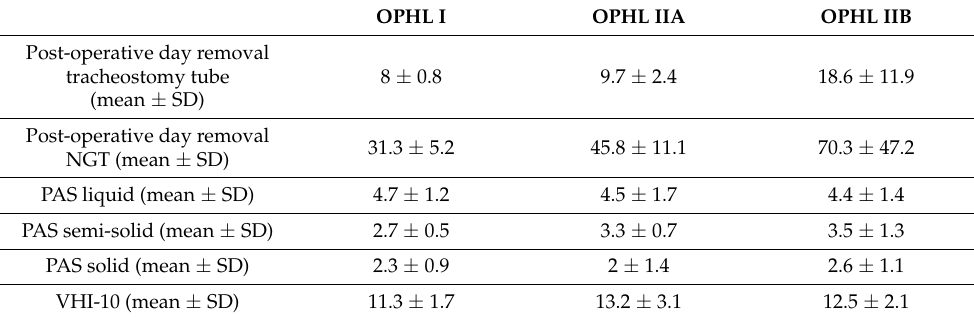
Table 5. Functional outcomes according to the type of